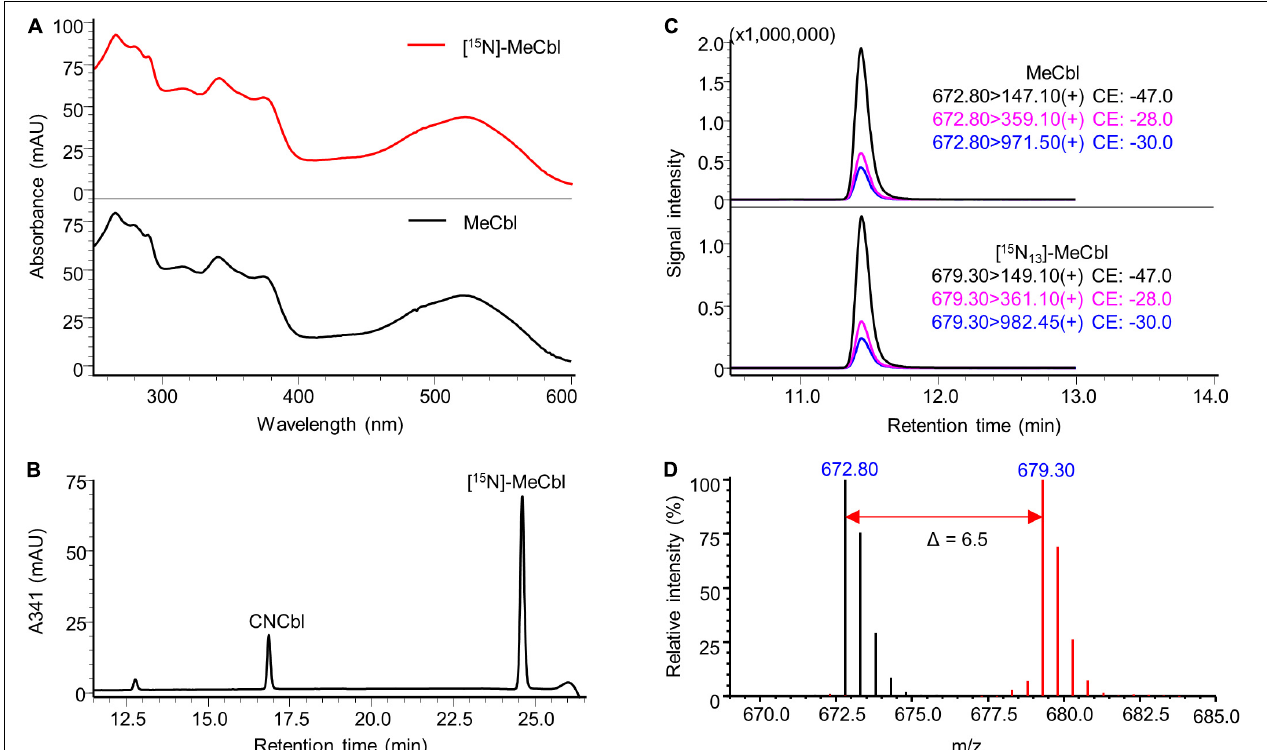
FIGURE 6 | Characterisation of prepared [ 15 N]-MeCbl. (A) UV-Vis spectrum of the prepared [ 15 N]-MeCbl in comparison to that of the MeCbl standard. (B) HPLC-DAD analysis at a wavelength of 341 nm of the product from methylation reaction showed a major peak of [ 15 N]-MeCbl at the same retention time of unlabelled MeCbl standard (see Supplementary Figure 6 ). (C) LC-MS/MS analysis of [ 15 N]-MeCbl monitoring mass transitions corresponding to [ 15 N 13 ]-MeCbl (lower trace). The LC-MS/MS chromatogram of unlabelled MeCbl is shown as a reference (upper trace). (D) Overlaid mass spectra of [ 15 N]-labelled MeCbl (red) and unlabelled MeCbl (black). The mass shift in [M + 2H] 2 + values indicated by the red arrow confirmed the labelling of 13 nitrogen atoms. MS spectra were acquired in selected ion monitoring (SIM) mode with a m/z interval of 0.5.